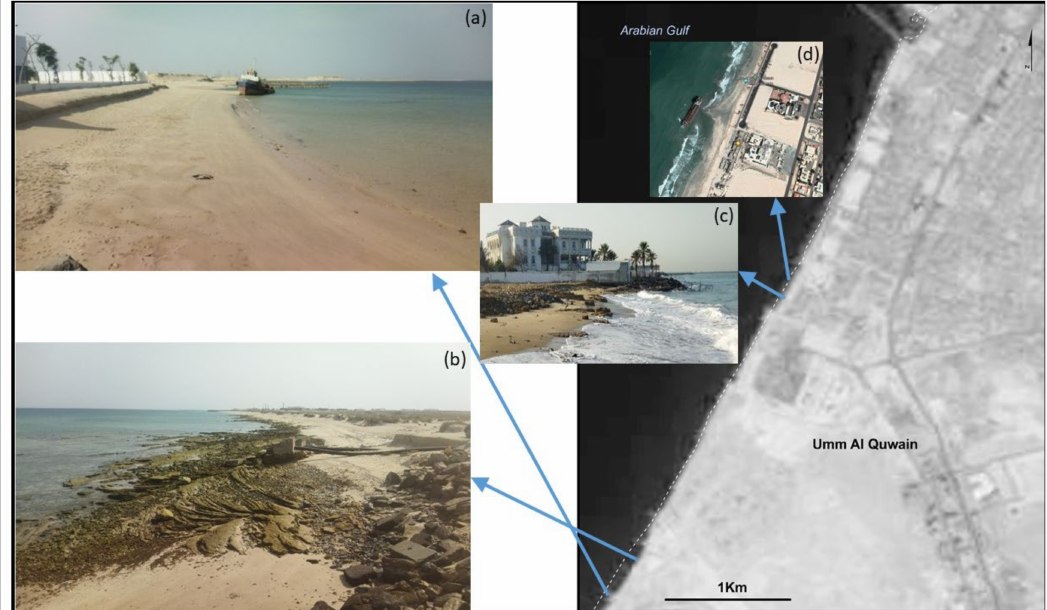
Figure 12. Landsat 7 Band 5 image dated 25th November 2021 showing the central part of the Umm Al Quwain front coast. The dashed line in white denotes the shoreline position in 1990. Insets ( b , c ) are pictures taken in the field displaying the nature of coastal retreat along the coast and ( a , d ) are shipwrecks placed to stop the erosion along the